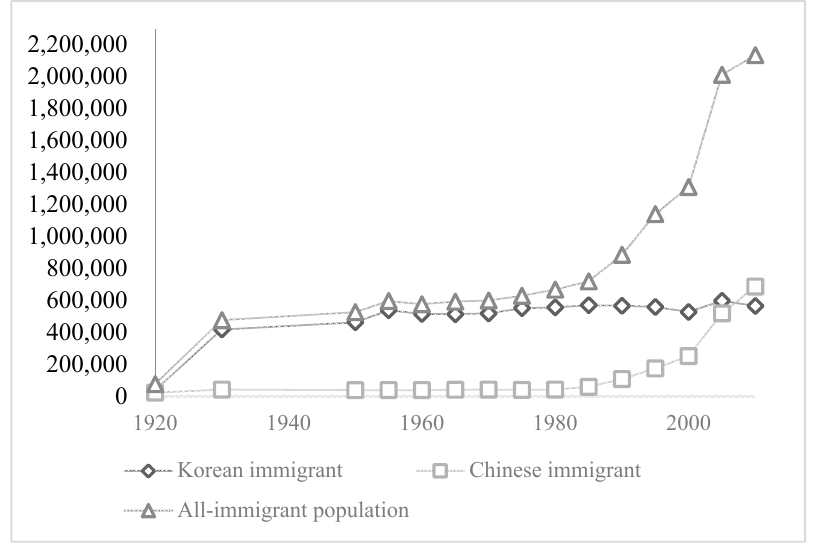
Figure 1. Time series trends of immigrant populations in Japan. Source: Japanese Census Data 1920–2010.